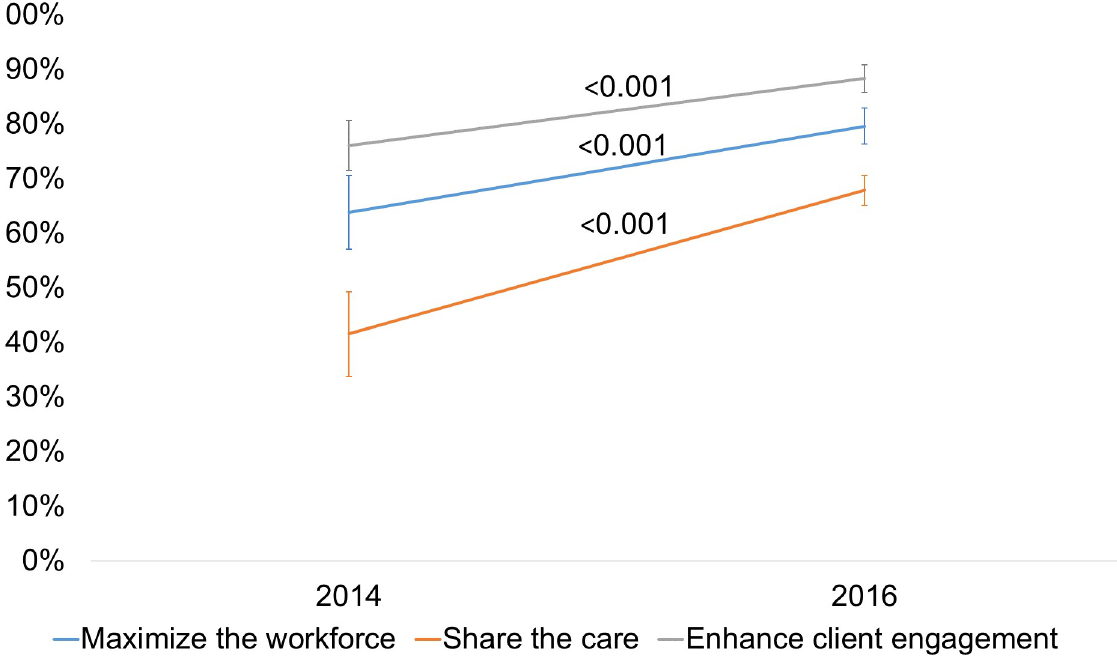
Fig 2. Changes in organizational assessment block scores from baseline to final assessment